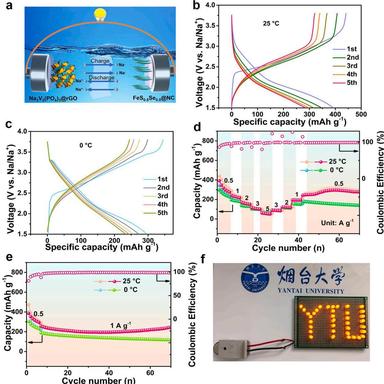
(a) Schematic diagram of Na3V2(PO4)3@rGO//FeS0.5Se0.5@NC full cell, (b) discharge–charge profiles at 0.5 A g− 1 at 25 ◦C, (c) discharge–charge profiles at 0.5 A g− 1 at 0 ◦C, (d) rate performances, (e) cycling performances at 1 A g− 1 at both 25 ◦C and 0 ◦C, (f) LEDs lighted up by Na3V2(PO4)3@rGO//FeS0.5Se0.5@NC sodium-ion full cell.